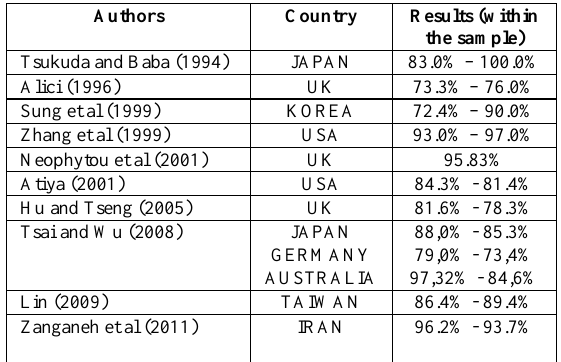
Table 1: Empirical evidence of bankruptcy prediction with NN (1 year).